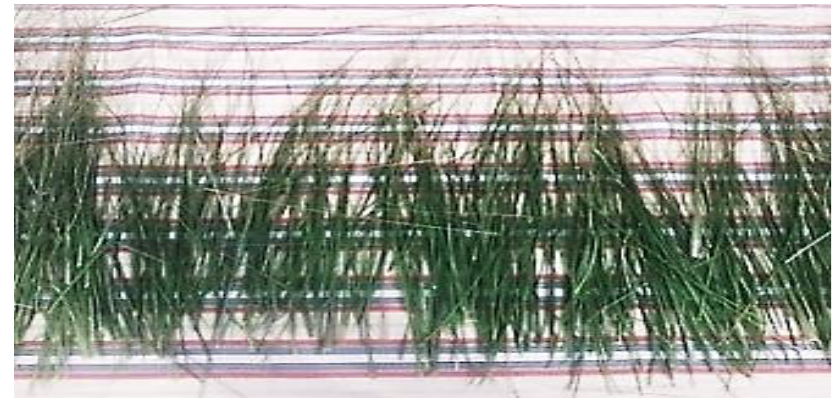
Figure 6. Diss fibers before grinding.